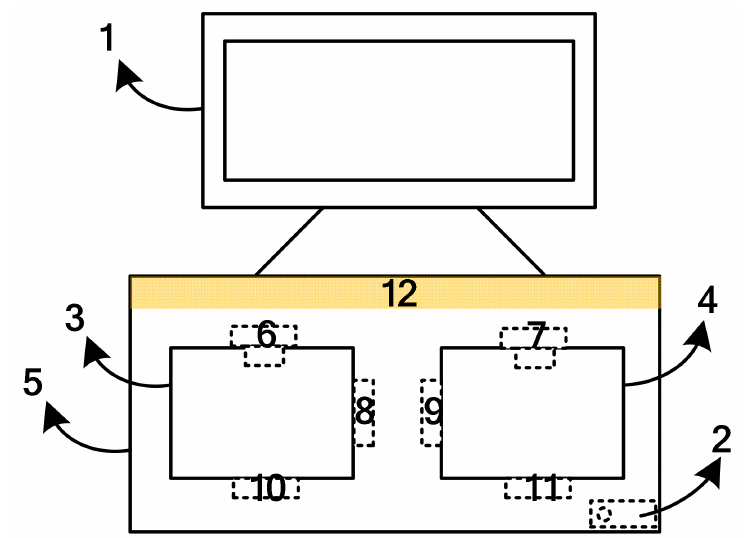
Figure 3. Block diagram of core hardware structure of hardware platform of multi-dimensional intel- ligent visual quantitative assessment system. 1—Touch display; 2—Computer; 3 and 4—Workspace; 5—External structure frame; 6 and 7—Video capture device; 8, 9, 10 and 11—Optical intelligent motion capture device and 12—Light